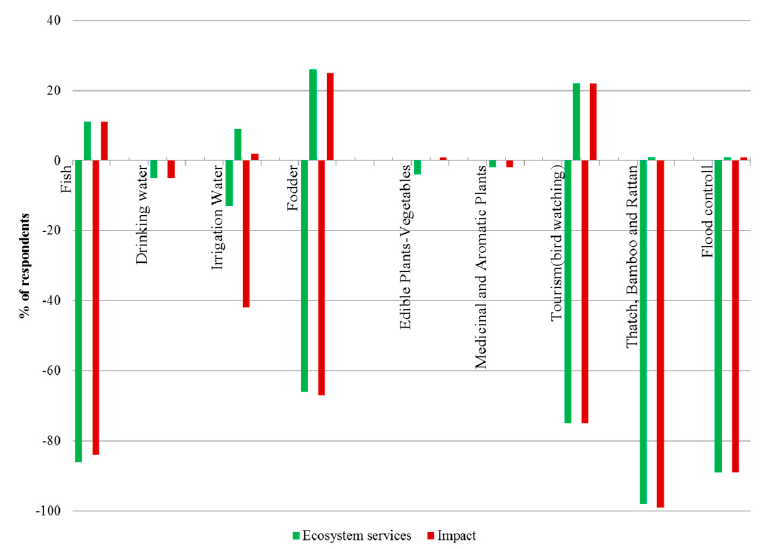
Figure 5. Impacts on ecosystem services derived through household surveys.